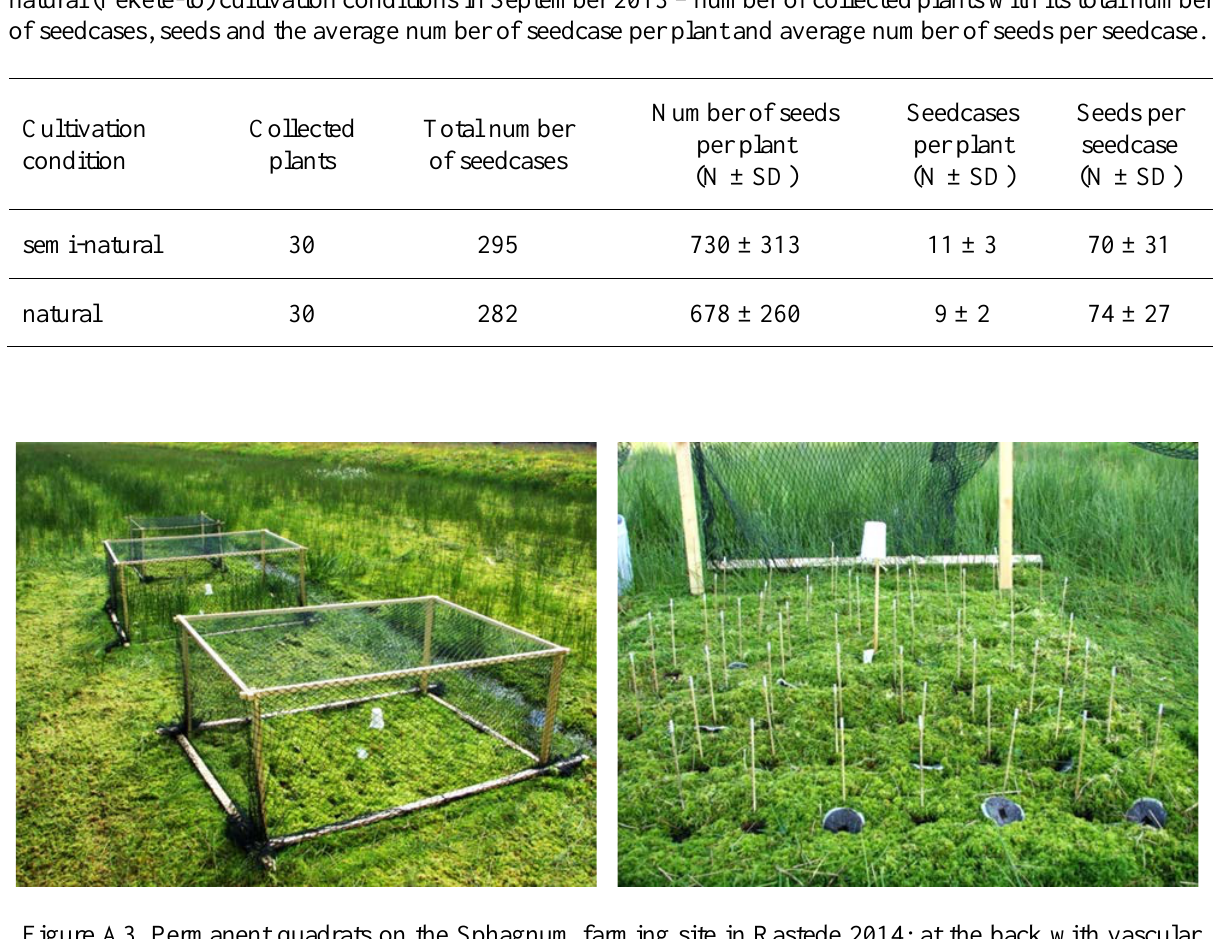
Figure A3. Permanent quadrats on the Sphagnum farming site in Rastede 2014: at the back with vascular plants and in the front without (left) and a permanent quadrat without vascular plants (right). Photos: Balázs